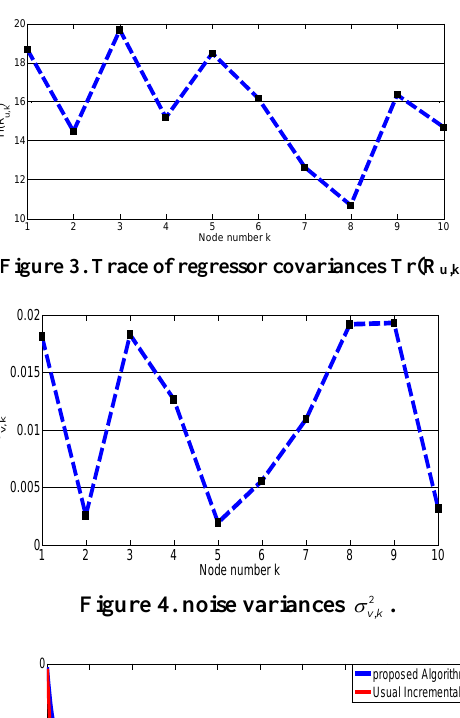
Figure 4. noise variances 2